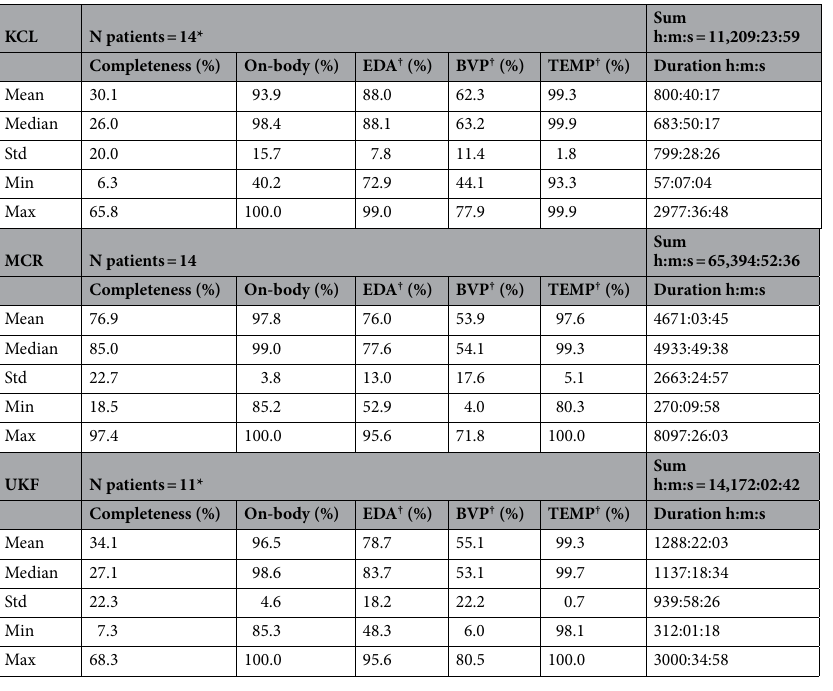
Table 5. Data quality results for the outpatient cohort data, presented as the aggregated scores for all participants of the respective cohort. We report the amount of data recorded between start and end of the recording as completeness. From this we test how long the device is worn on the body, and score the signal quality of the modalities EDA, BVP, and TEMP. Additionally we report the duration of the recorded data